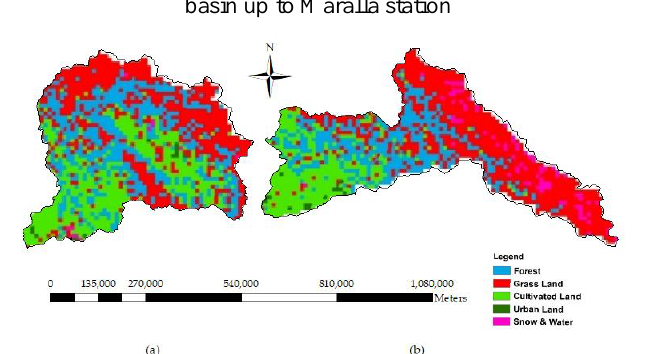
Fig. 5. Land use/cover classification imported in IFAS model (a) Jhelum river basin (b) Chenab river basin